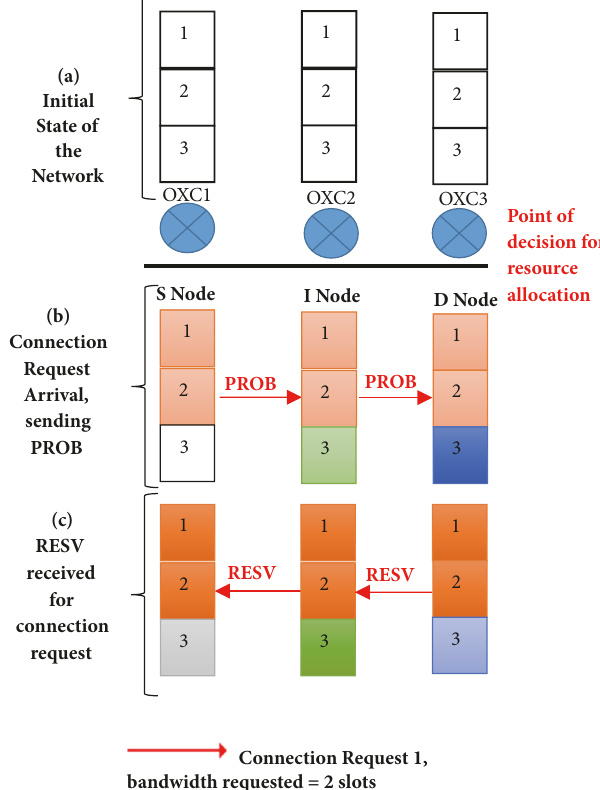
Figure 5: An illustration of the frequency slots in an EON being reserved using RSVP-TE–BRP